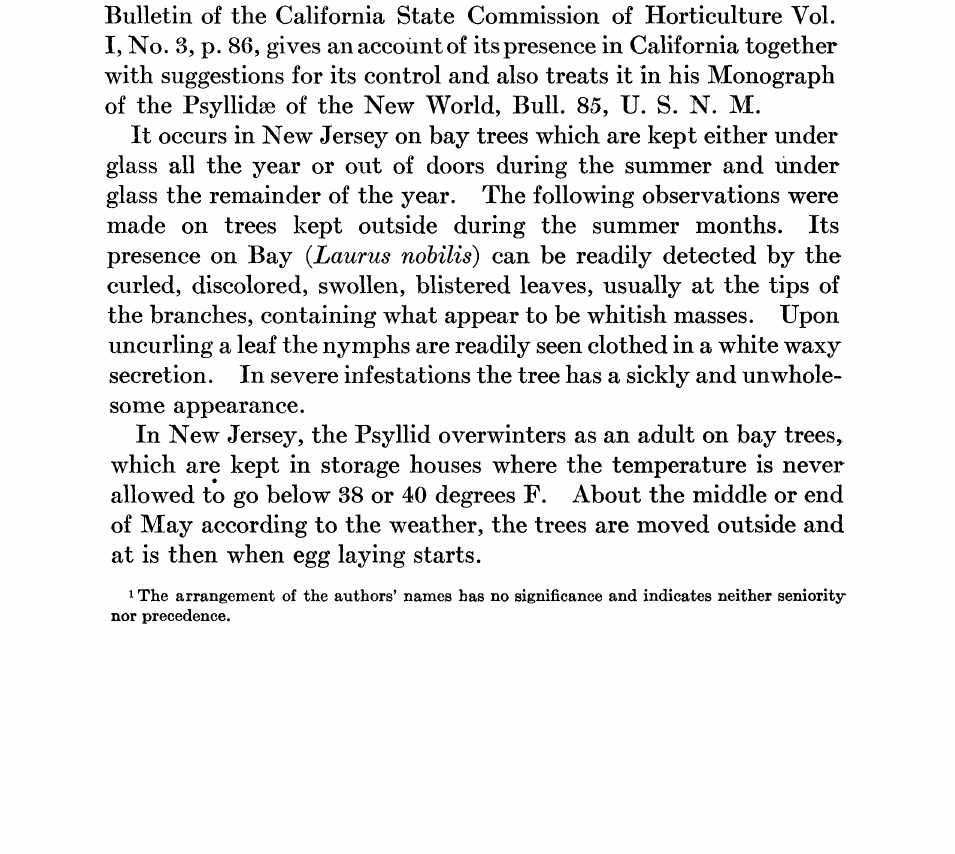
:Fig. 6. Panorpa nebulosa, Westw. (M:ecoptera), ventral. :Fig. 7. Panorpodes of Fig. 19, ventral. Fig. 8. Nannochorista dipteroides, Tillyard (M:ecoptera), dorsal view, based on Fig. 11 of Plate XVII, by Tillyard, 1917 (Proc. Linn. Soc. N. S. W.). Fig. 9. Merope tuber, Newm. (M:ecoptera), ventral. Gono- pods cut off. Fig. 30. Philopotamus Sp. n.? (Trichoptera),